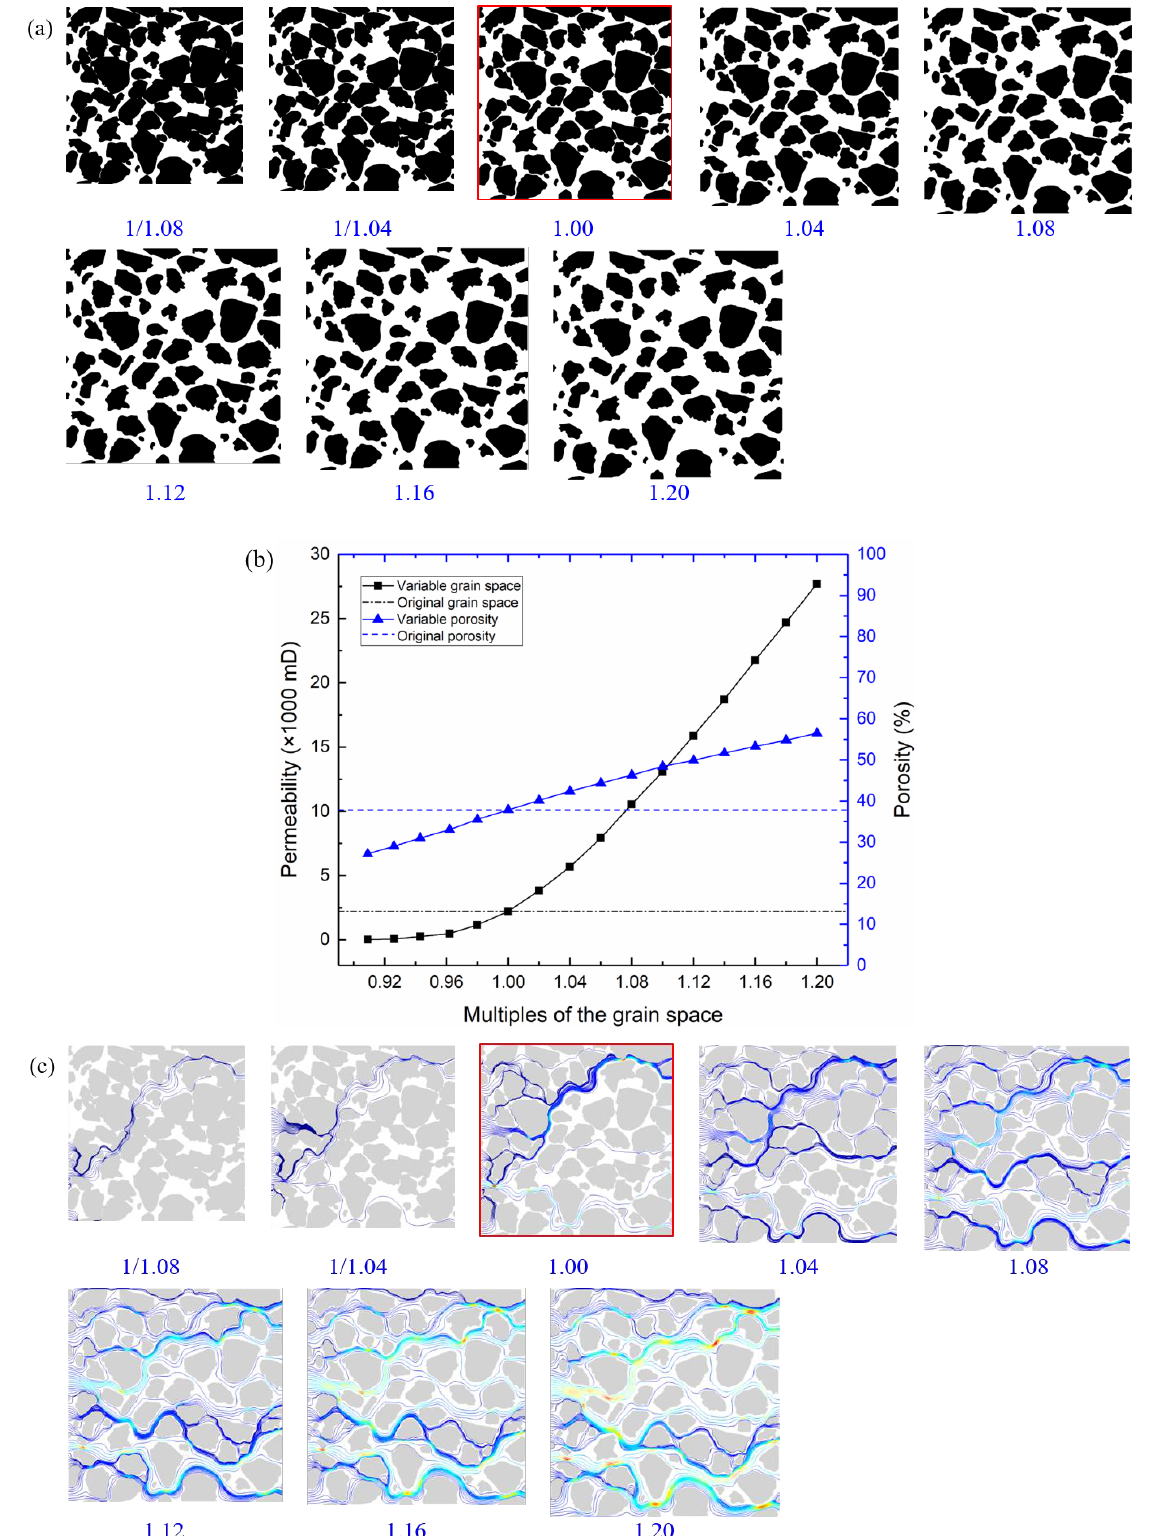
Figure 14. Influence of grain space on permeability. ( a ) Pore models with different grain spaces; ( b ) porosity and permeability of pore models with different grain spaces; ( c ) flow paths and velocity of pore models with different grain